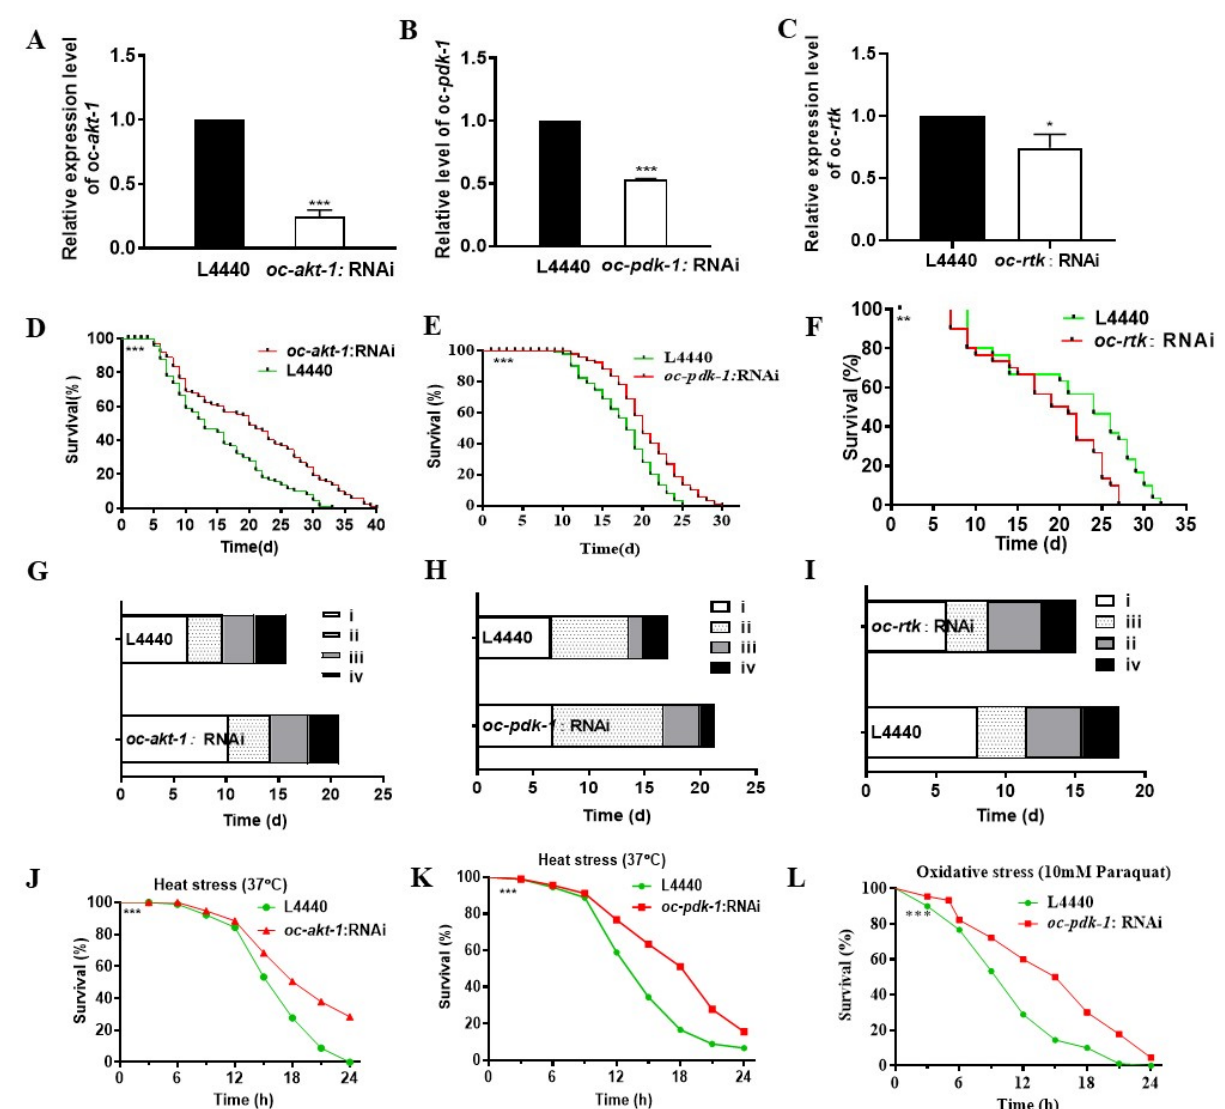
RNAi O. chongmingensis than those in the corresponding control group (Figure 3A–C). Longevity and tolerance to heat stress were significantly prolonged in oc-akt-1 :RNAi and oc-pdk-1 :RNAi O. chongmingensis (Figure 3D,E,G,H,J,K). By contrast, longevity was reduced in oc-rtk :RNAi O. chongmingensis nematodes (Figure 3F,I). The oc-pdk-1 :RNAi nematodes also gained increased oxidative stress tolerance (Figure 3L). These results revealed that downregulating the expression of oc-daf-16, oc-fak , and oc-rtk decreased longevity and stress tolerance, whereas downregulating oc-pdk-1 and oc-akt-1 induced longevity extension and stress resistance enhancement in O. chongmingensis .